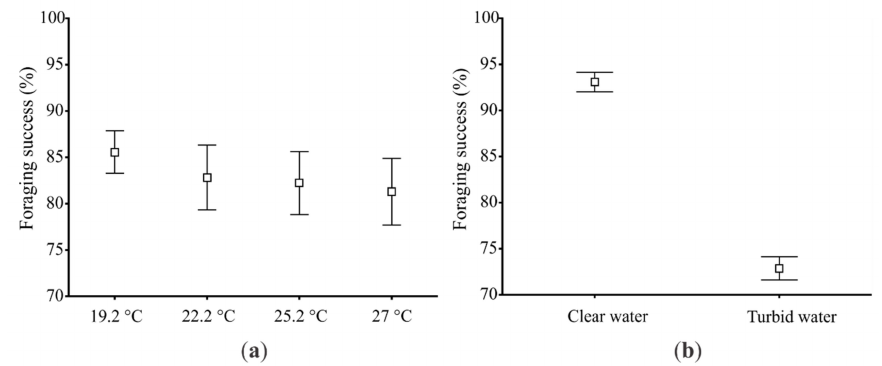
Figure 1. The main e ff ects of temperature and turbidity on the foraging success of Gymnogeophagus terrapurpura on Hyalella curvispina , at di ff erent water temperatures ( a ), in clear (3 NTU) and turbid water (100 NTU) ( b ). Data show mean and standard errors, after pooling the data from the levels of the factor not shown. Foraging success was significantly higher in clear than in turbid waters ( b ), while no significant e ff ect of water temperature on the foraging success of G. terrapurpura was detected ( a